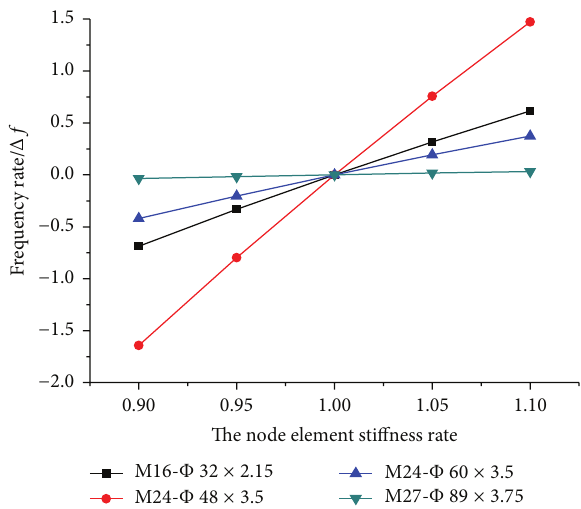
Figure 8: The influence of node element stiffness of connection in different types to the fundamental